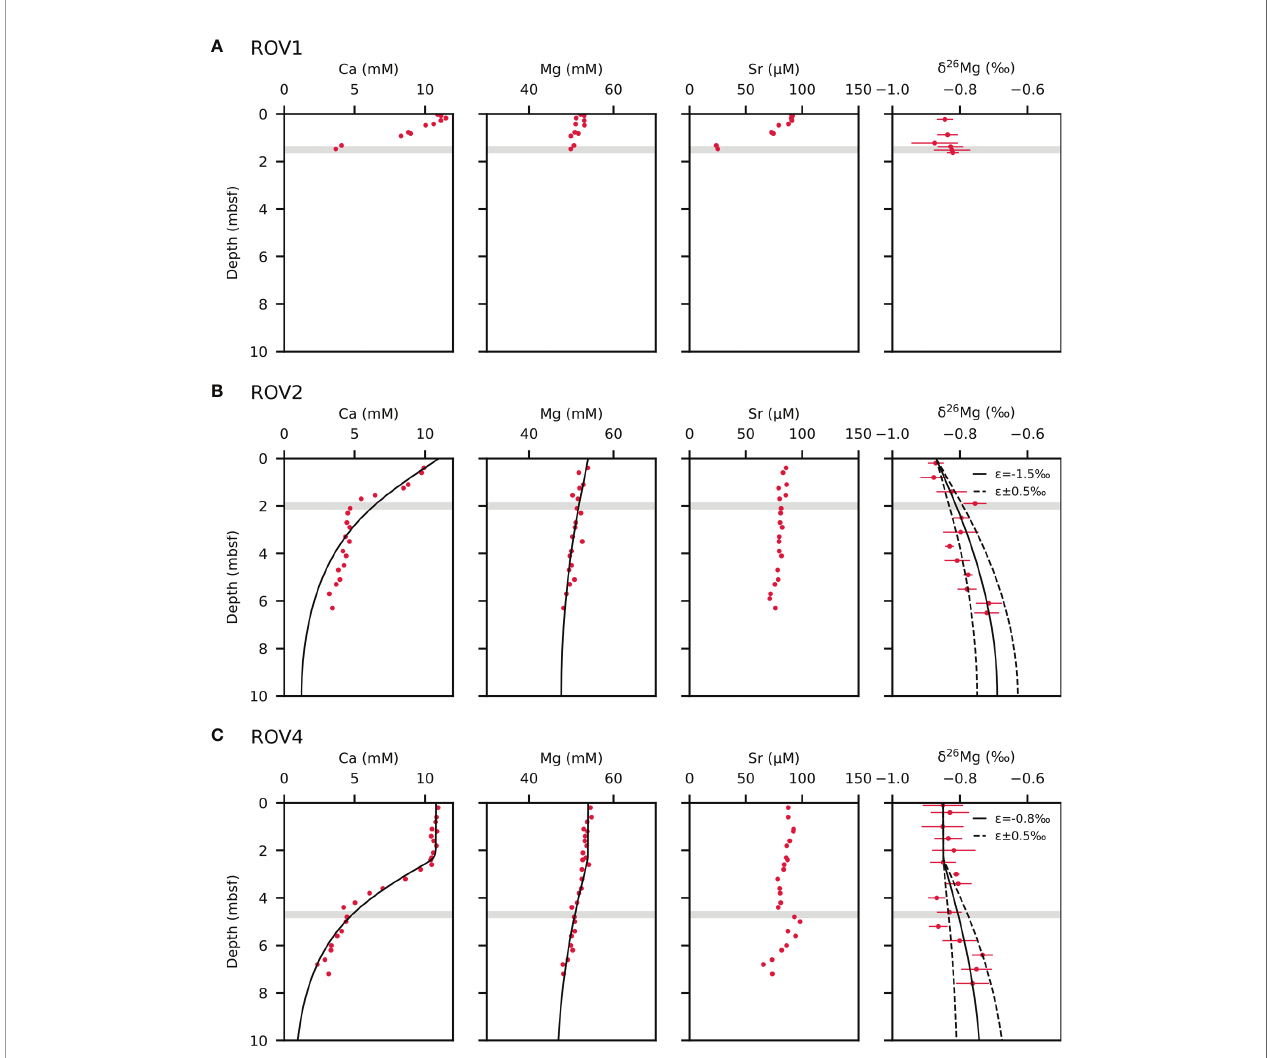
FIGURE 3 | Pore water pro fi les of calcium (Ca 2+ ), magnesium (Mg 2+ ), strontium (Sr 2+ ) concentrations, and d 26 Mg values for cores ROV1 (A) , ROV2 (B) , and ROV4 (C) . Dots are measured data and solid lines are model results. Uncertainties in modeled fractionation factors ( ϵ ) are calculated by varying fractionation factors by ±0.5 ‰ indicated by the dotted lines. The “ mbsf ” refers to meters below sea fl oor. The shaded bar marks the sulfate-methane transition zone